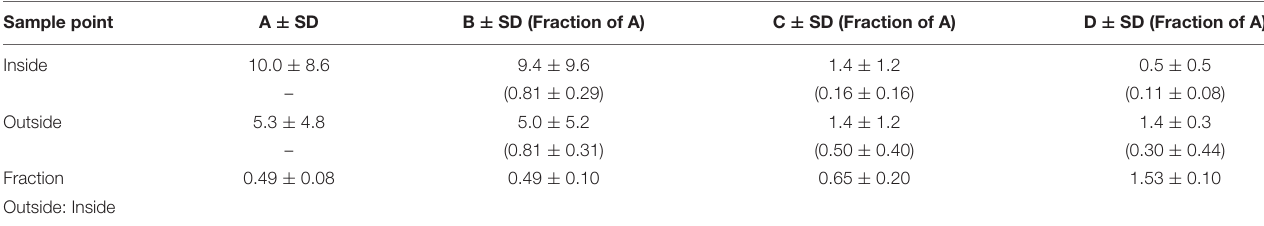
TABLE 4 | Mean abundance ( ± SD) of planktonic sea lice (individuals m − 3 ) found in each sample point A to D (columns) and, in parenthesis, the fraction of that sample point relative to sample point A ( ± SD). Sample